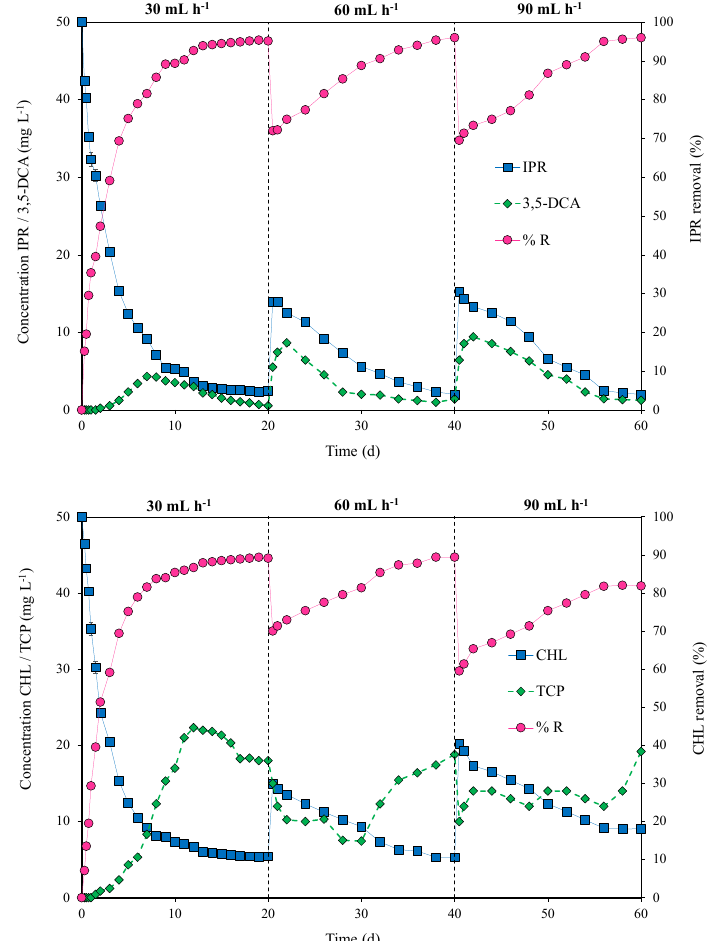
Figure 5. Pesticide concentrations/metabolites (mg L − 1 ) in the effluent and removal efficiency (% R) for iprodione (IPR) and chlorpyrifos (CHL) fed (in mixture) at a concentration of 50 mg L − 1 each in a packed-bed bioreactor operated at different flow rates (30, 60, and 90 mL h − 1 ) over time (0 to 60 days) and inoculated with an immobilized bacterial consortium at an inoculum concentration of 15% w/v .